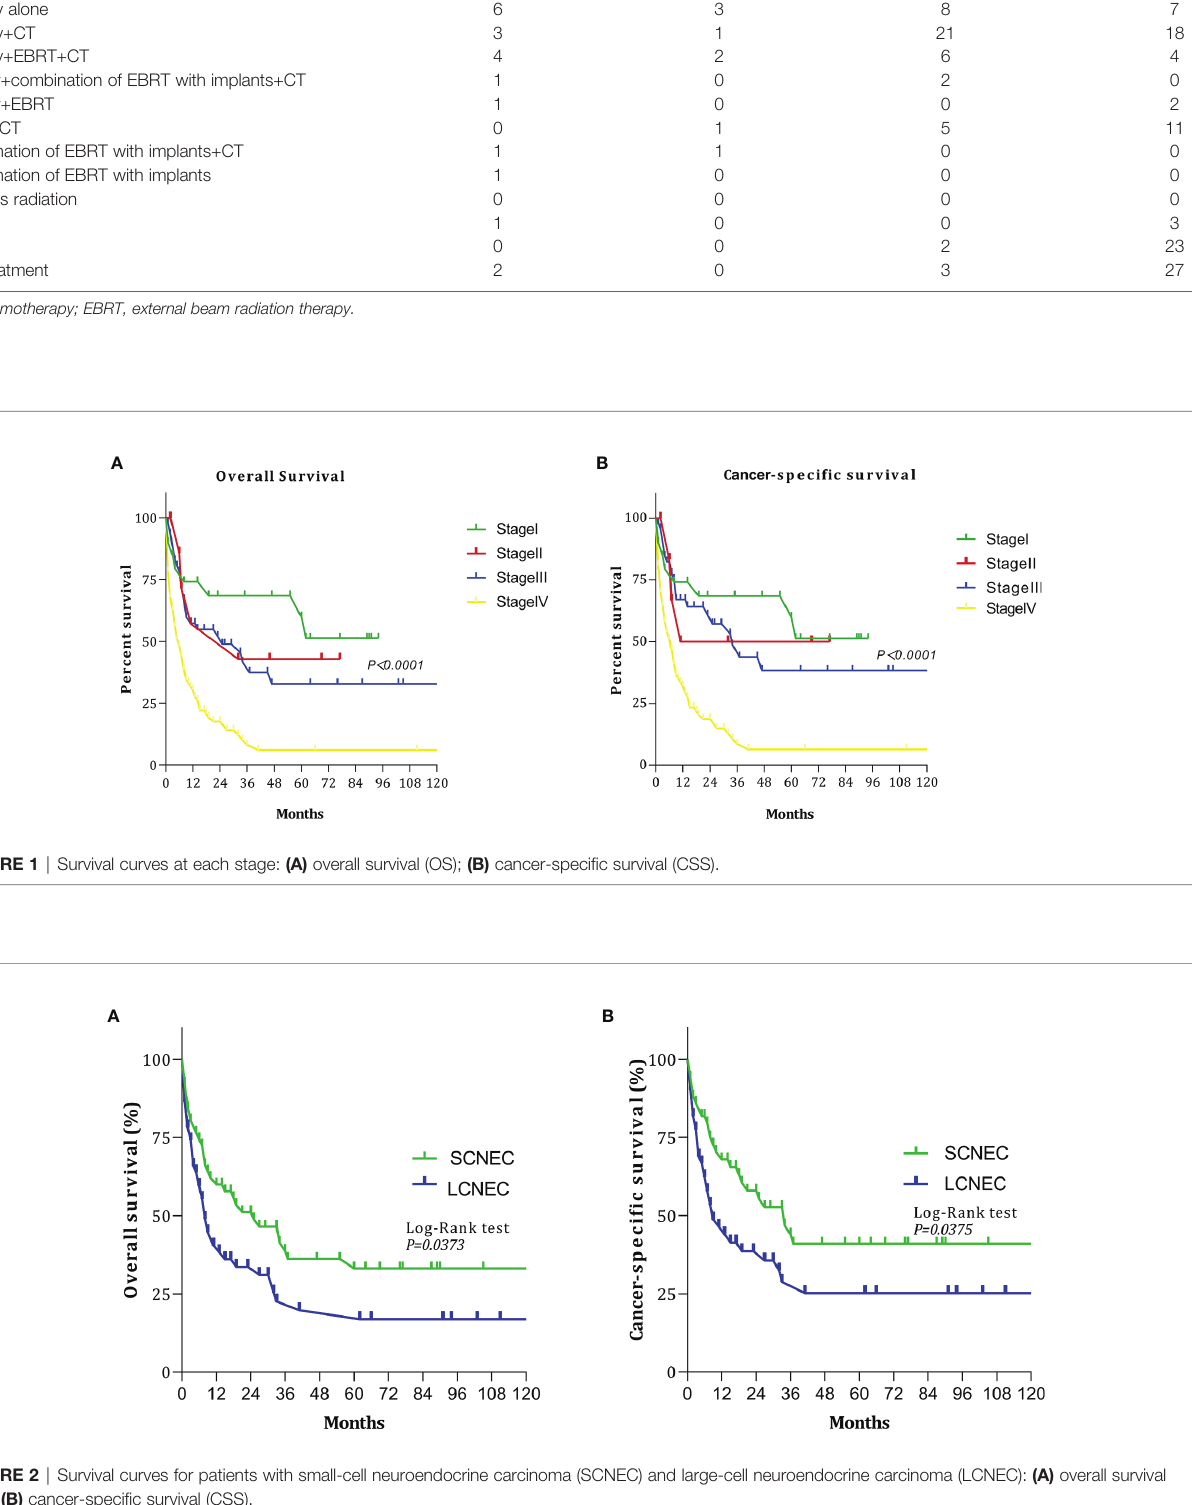
StageI StageII StageIII StageIV n=20